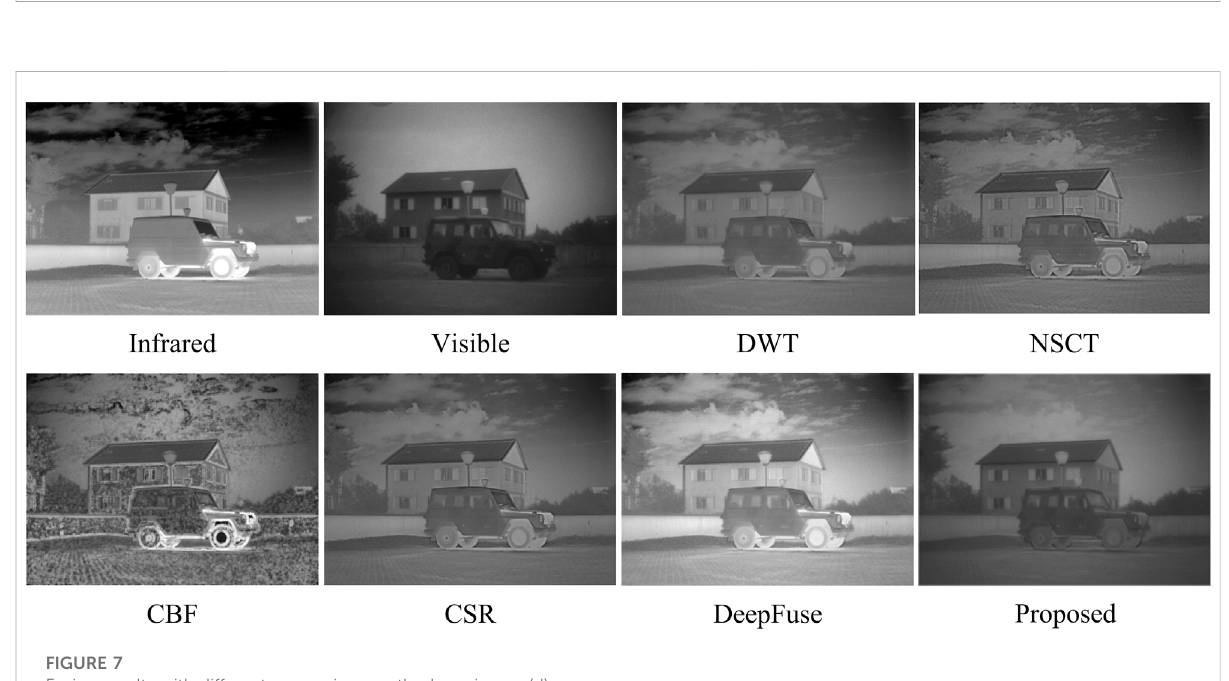
FIGURE 7 Fusion results with different comparison methods on image